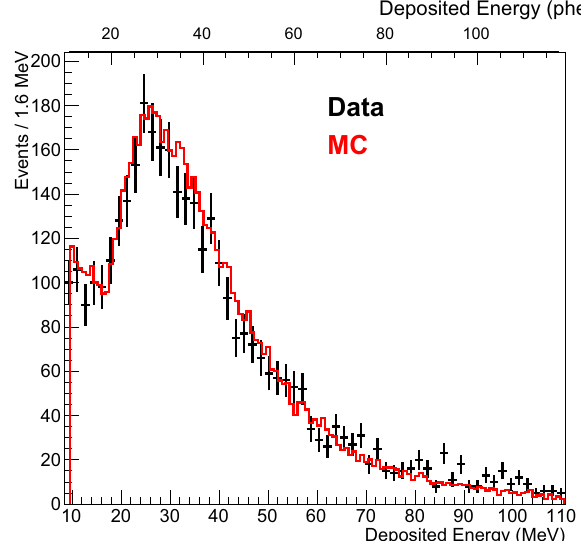
Fig. 7 Cosmic-rays energy deposition spectrum in a single PbWO 4 crystal: data are shown in black, while simulations results are reported in